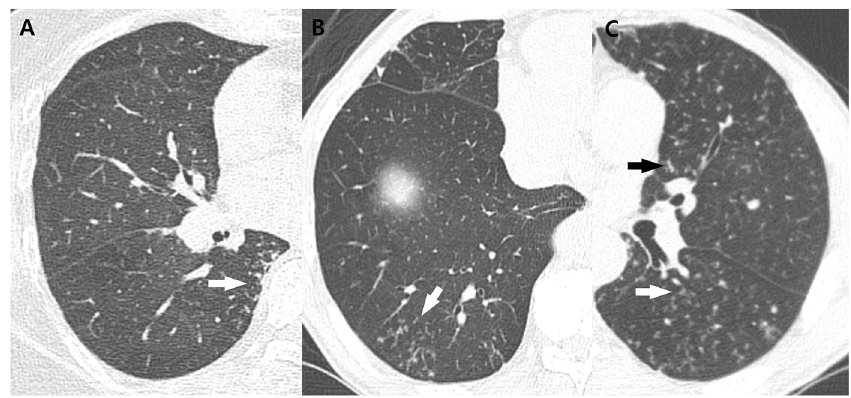
Fig 3. Examples of cellular bronchiolitis to CT scoring of MAC lung disease. (A) Mild cellular bronchiolitis in superiorsegment of right lower lobeof 67-year-old woman, scored as 1 point, manifesting as tree-in-bud patterns in the peripheral lung, 1 cm from the pleura(arrow). (B) Moderate cellularbronchiolitis in posterior basal segment of right lower lobeof 73-year-old man, scored as 2 points, showingcentrilobular nodulesor tree-in-budpatterns involvedgreater than 1–3 cm from the pleura(arrow). (C) Severe cellular bronchiolitis in superiorsegment of left lower lobe and lingularsegment of left upper lobe of 59-year-old man, scored as 3 points, showingcentrilobularnodulesor tree-in-bud patterns extendingto the central lung (arrows).